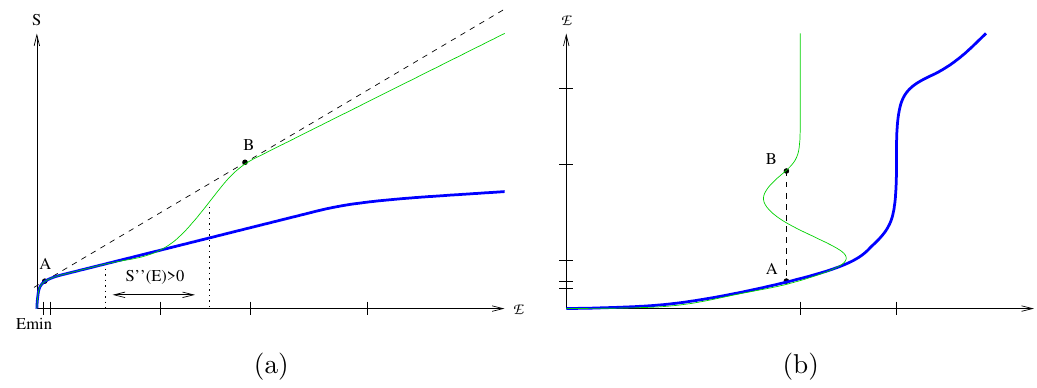
Figure 2 . (a) S ( E ) when 1 /c 1 N (cid:28) µ/R 2 (cid:28) 1 in linear plot is illustrated schematically in green. The same data was also illustrated in green in figure 1(a) in a log-log plot. In order to fit all of the features in one plot, this figure is not drawn to scale. For large E , the entropy S ( E ) asymptotes to grow linear in E due to the Hagedorn spectrum of the T ¯ T deformation. The dotted line between the points A and B indicates the effect of Gibbsian ruling which eliminates the region which contians the interval with negative specific heat (where S 00 ( E ) > 0 ) and gives rise to a first order phase transition. The slope of the S ( E ) curve corresponds to T − 1 . This plot shows that the temperature associated with the Gibbsian ruling illustrated using the dotted line is slightly smaller than the temperature associated with the Hagedorn temperature of the T ¯ T deformation. The dotted line is tangent to the S ( E ) curve at points A and B . Point B appears in figure 1(a). Point A appears as a result of almost parallel lines meeting at ∆ ∼ O (1) because of O (1) corrections which are hard to see in the logarithmic scale used in figure 1(a). The five tick marks on the horizontal axis corresponds p p to E − E min of order exp( − c 1 Nµ/R 2 ) /R , 1 /R , R/µ , c 1 N/µ , and c 1 N/R , respectively in the p increasing order. It should be stressed that B occurs near E ∼ c 1 N/µ which is set hierarchically (cid:16) (cid:17) p larger than A which is at E − E min ∼ exp − c 1 Nµ/R 2 . The blue line is S ( E ) of the symmetric orbifold theory without any T ¯ T -deformation. At E ∼ c 1 N/R (the right most tick mark), the blue √ curve is crossing over from the Hagedorn behavior S ∼ RE to Cardy behavior S ∼ c 1 NRE. (b) E ( T ) for the same system. The five tick marks on the E axis are the same as plot (a). The tick √ marks on the T axis corresponds to T = T T ¯ T ∼ 1 / c 1 Nµ and T = T HP ∼ 1 /R H